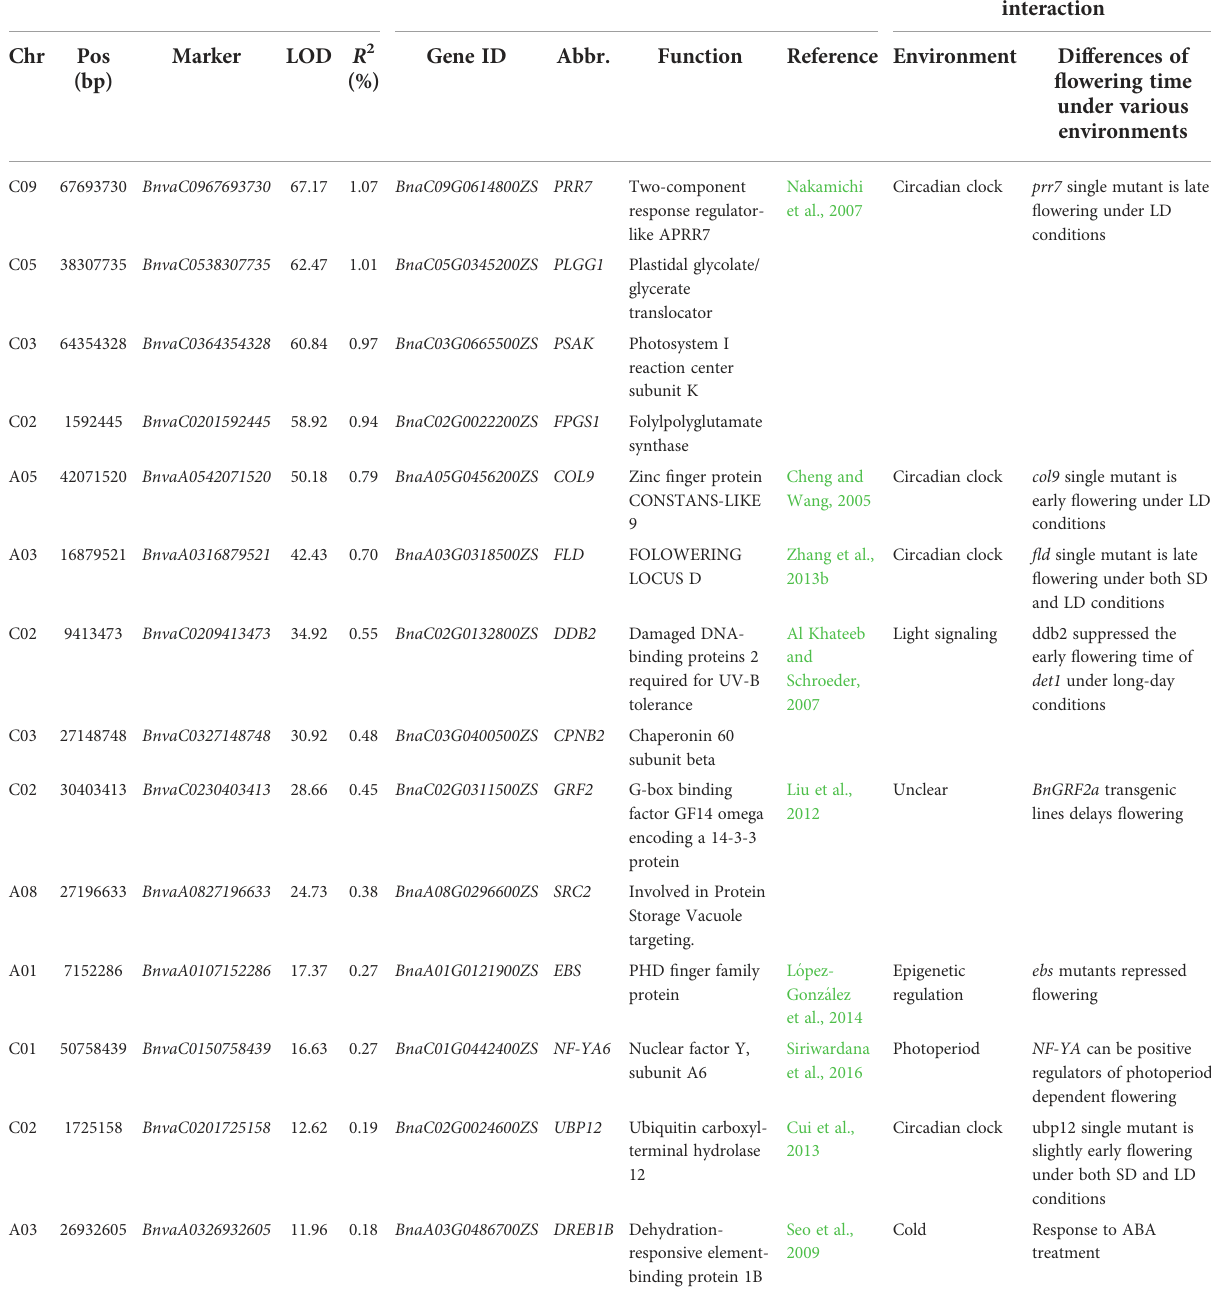
TABLE 2 Fourteen candidate genes for B. napus fl owering time around signi fi cant QTN-by-environment